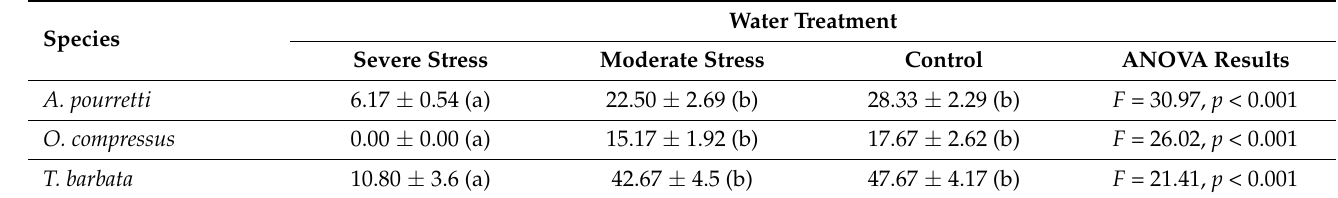
Table 2. Mean values ( ± SE) of the number of flowers ( O. compressus ) or inflorescences ( A. pourretti, T. barbata ) of plants grown under severe water deficit (S), moderate water deficit (M) and control (C) conditions and results from the one-way ANOVA testing for the effect of water treatment. Significant differences at p < 0.05 among treatments are indicated by different